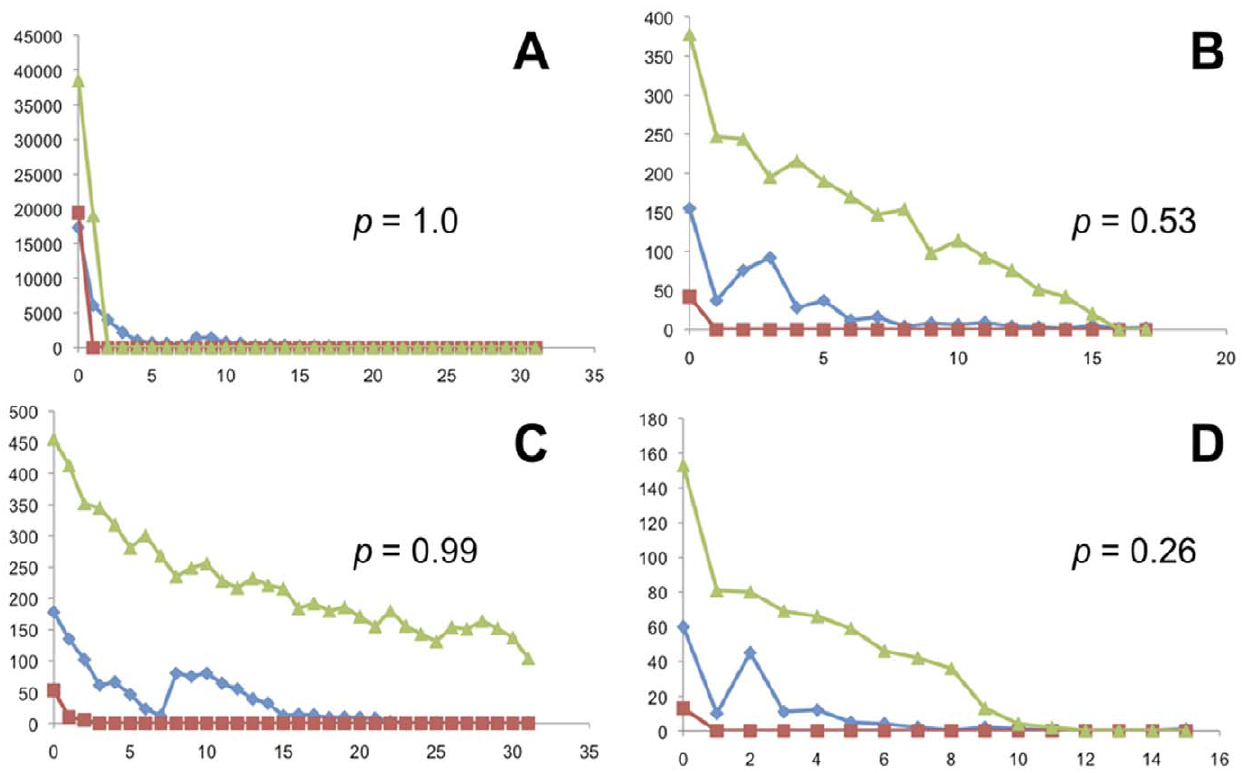
Figure 6. Mismatch distributions. The frequency distribution of nDNA polymorphisms within STRUCTURAMA-inferred populations calculated with the concatenated dataset in Arlequin. X-axes are in number of differences and Y-axes are in number of observations. Blue diamonds represent the observed data, green triangles and red squares represent upper and lower bounds expected under a model of expansion, respectively. P-values of the raggedness index for each analysis are given. A: Gulf-Atlantic. B: Suwannee. C: Carolinas. D: Everglades.